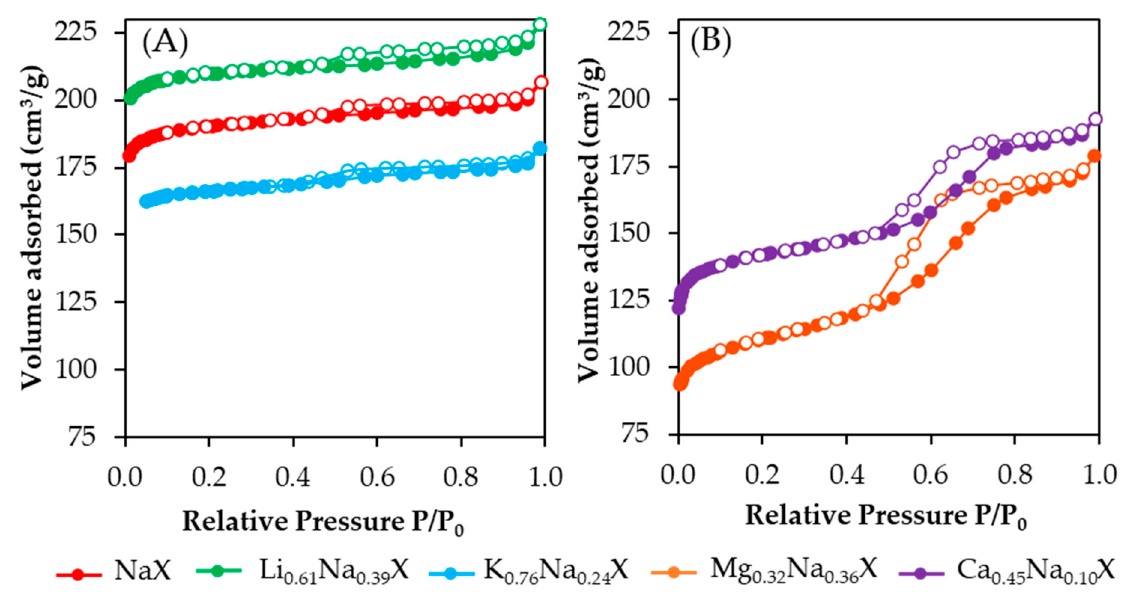
Figure 2. N 2 adsorption-desorption isotherms of zeolite samples containing the monovalent ( A ) and divalent cations ( B ). Full and empty circles denote the adsorption and desorption process, respectively.